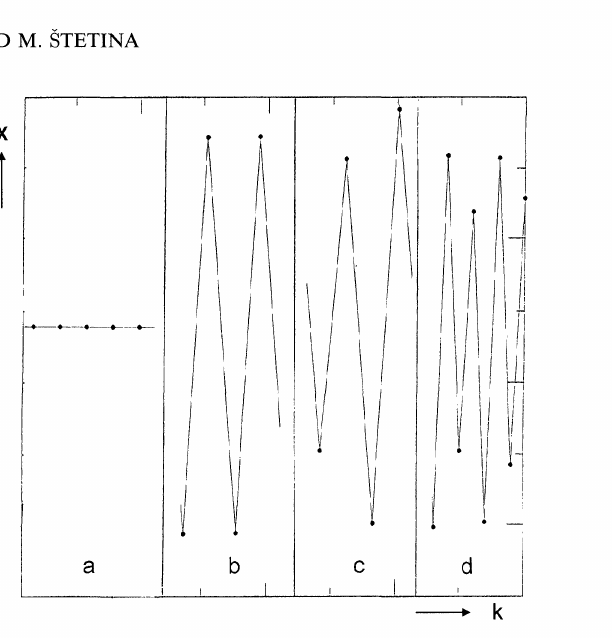
Time dependence of the quantity X on the number of steps (B1 2.0, C 3.2, A2 3.2, B2= 3.2,